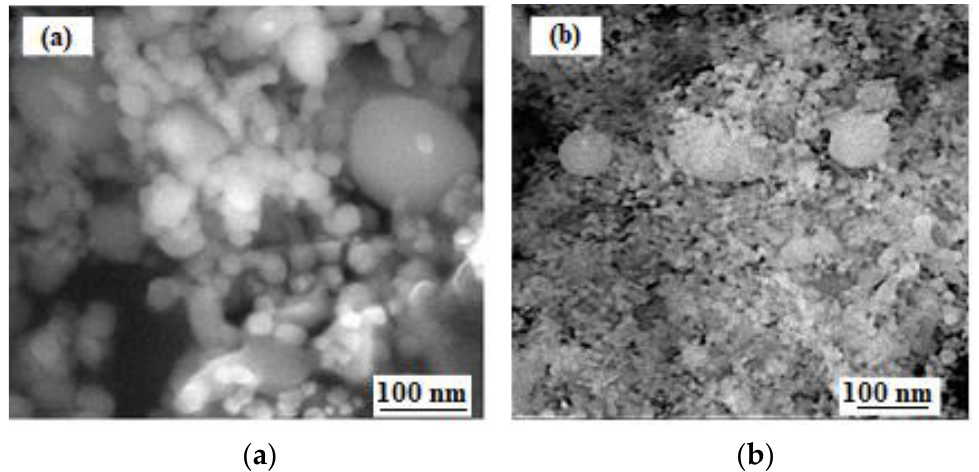
Figure 1. SEM images in the secondary electrons of zirconium oxide ( a ) and aluminum-magnesium spinel ( b ) nanopowders.